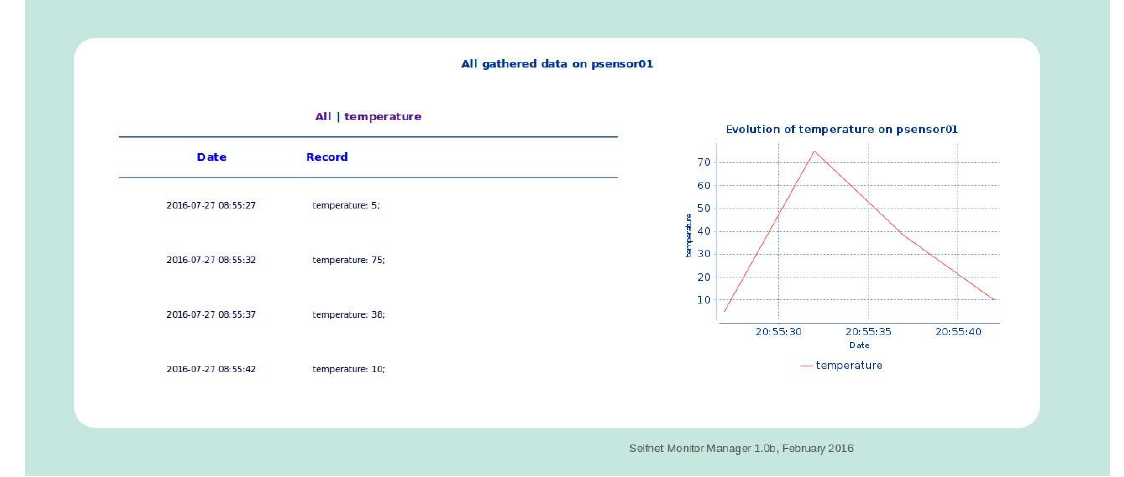
Figure 19. Details of information gathered by a SELFNET Sensor.